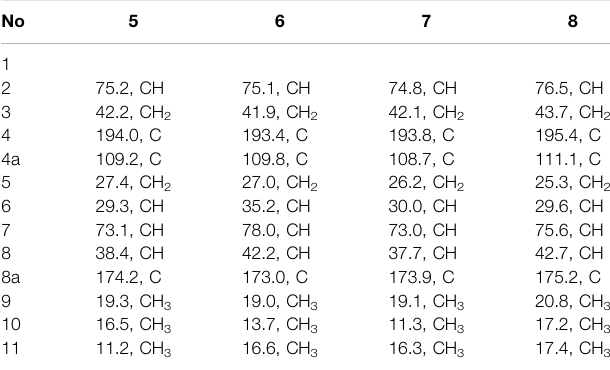
TABLE 4 | 13 C (125 MHz) NMR data for compounds 5 – 8 in CD 3 OD ( δ in